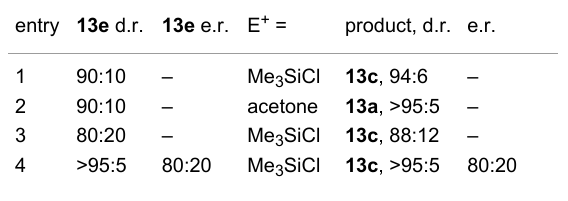
Table 3: Stereospecificity in the tin–lithium exchange/quench reac- tions. entry 13e d.r. 13e e.r. E + =